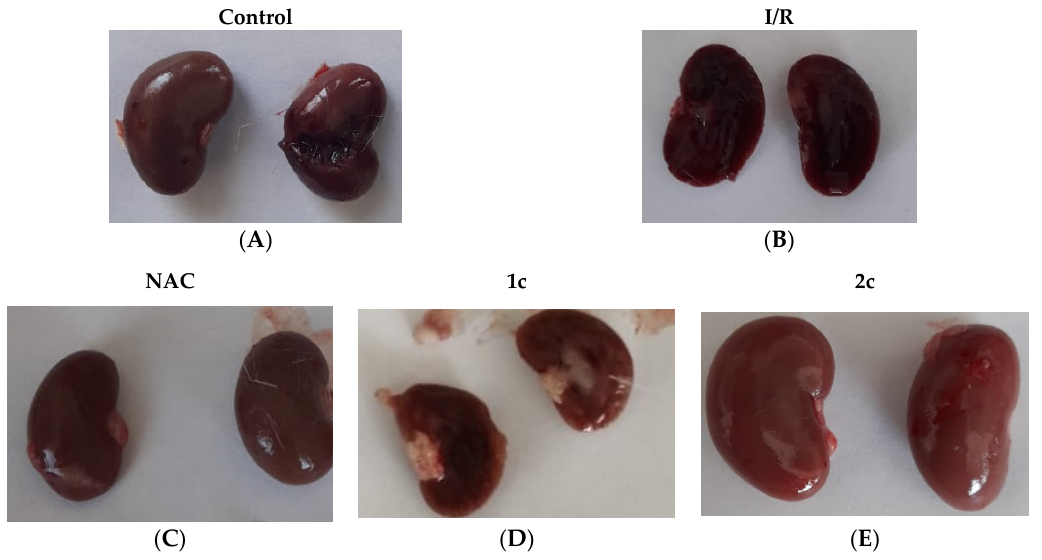
Figure 4. Photos of kidneys for groups of control ( A ) , I/R ( B ), reference (NAC) ( C ), and treated with compounds 1c ( D ) and 2c ( E ), as concentrations were measured in serum to detect renal injury due to ischemia/reperfusion (I/R).